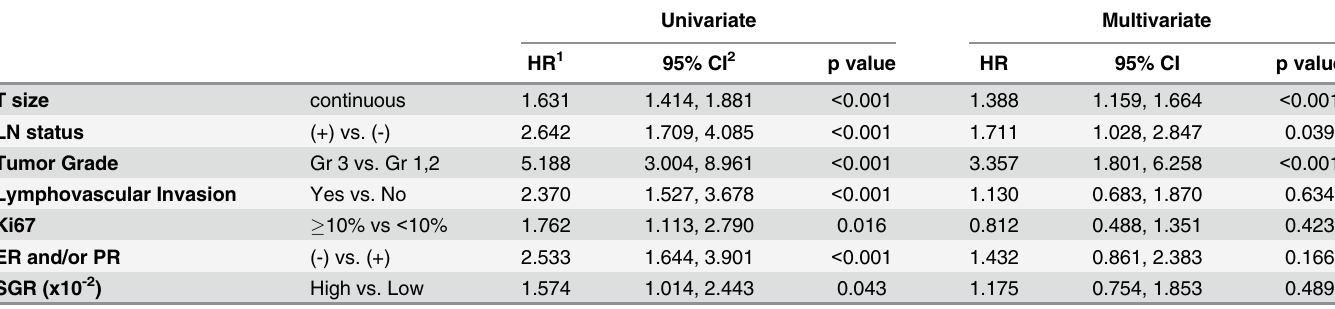
Table 2. Cox regression analysis for DFS.